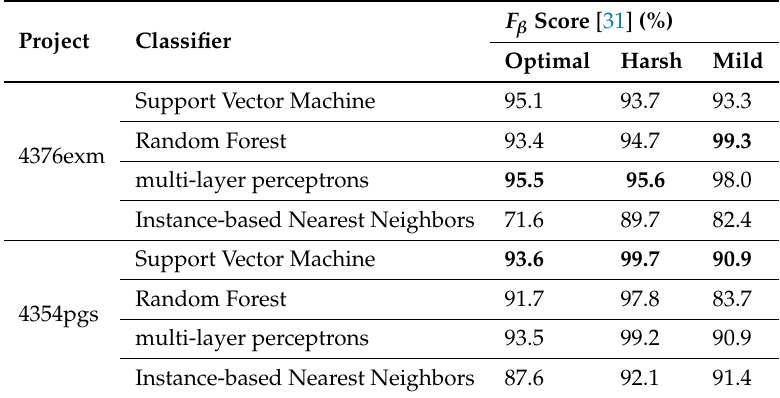
Table 2. Classification performance of different models applied to two projects (4376exm and